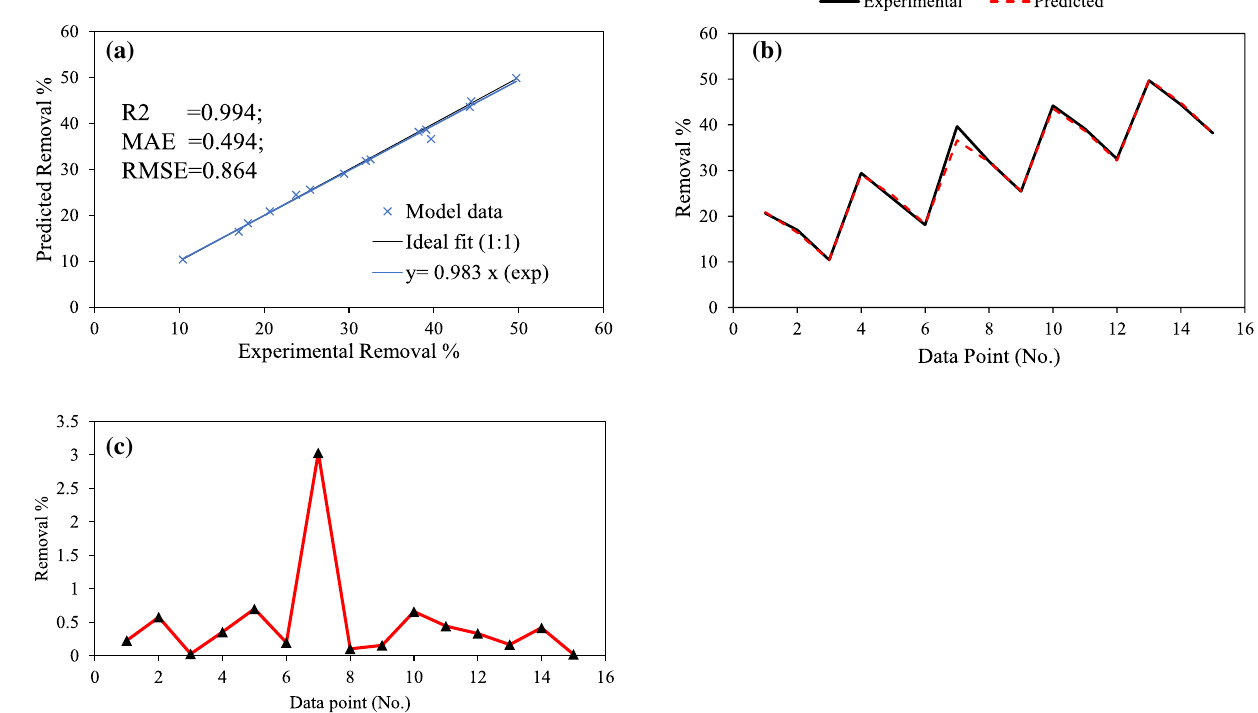
Fig. 1 Performance of the R t model a experimental versus predicted slope, b tracing of experimental values by the predictions and c error analy-